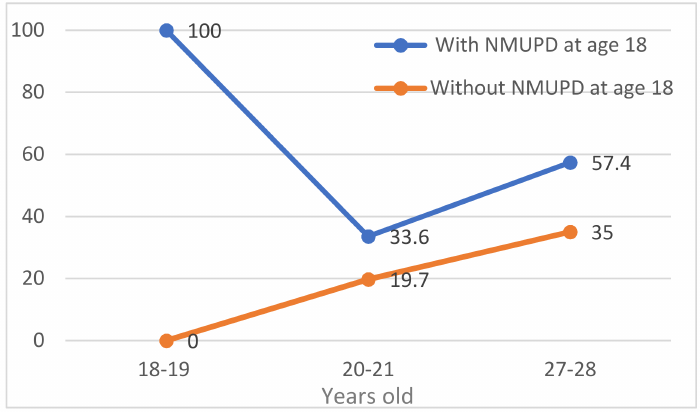
Figure 1. Trends in non-medical use of prescription drugs (NMUPD) (%) among women who already partook and who did not partake in this type of drug use at the beginning of the